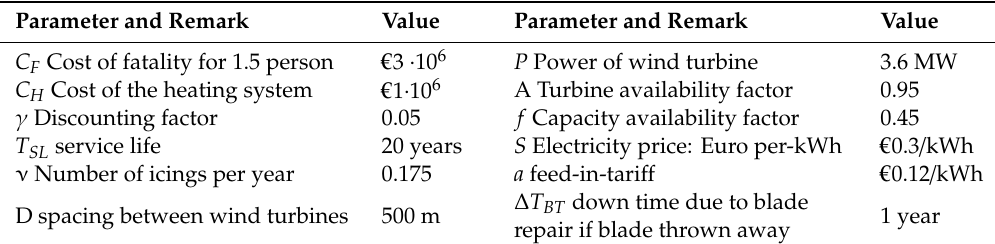
Table 2. Summary of costs and benefits analysis parameters.